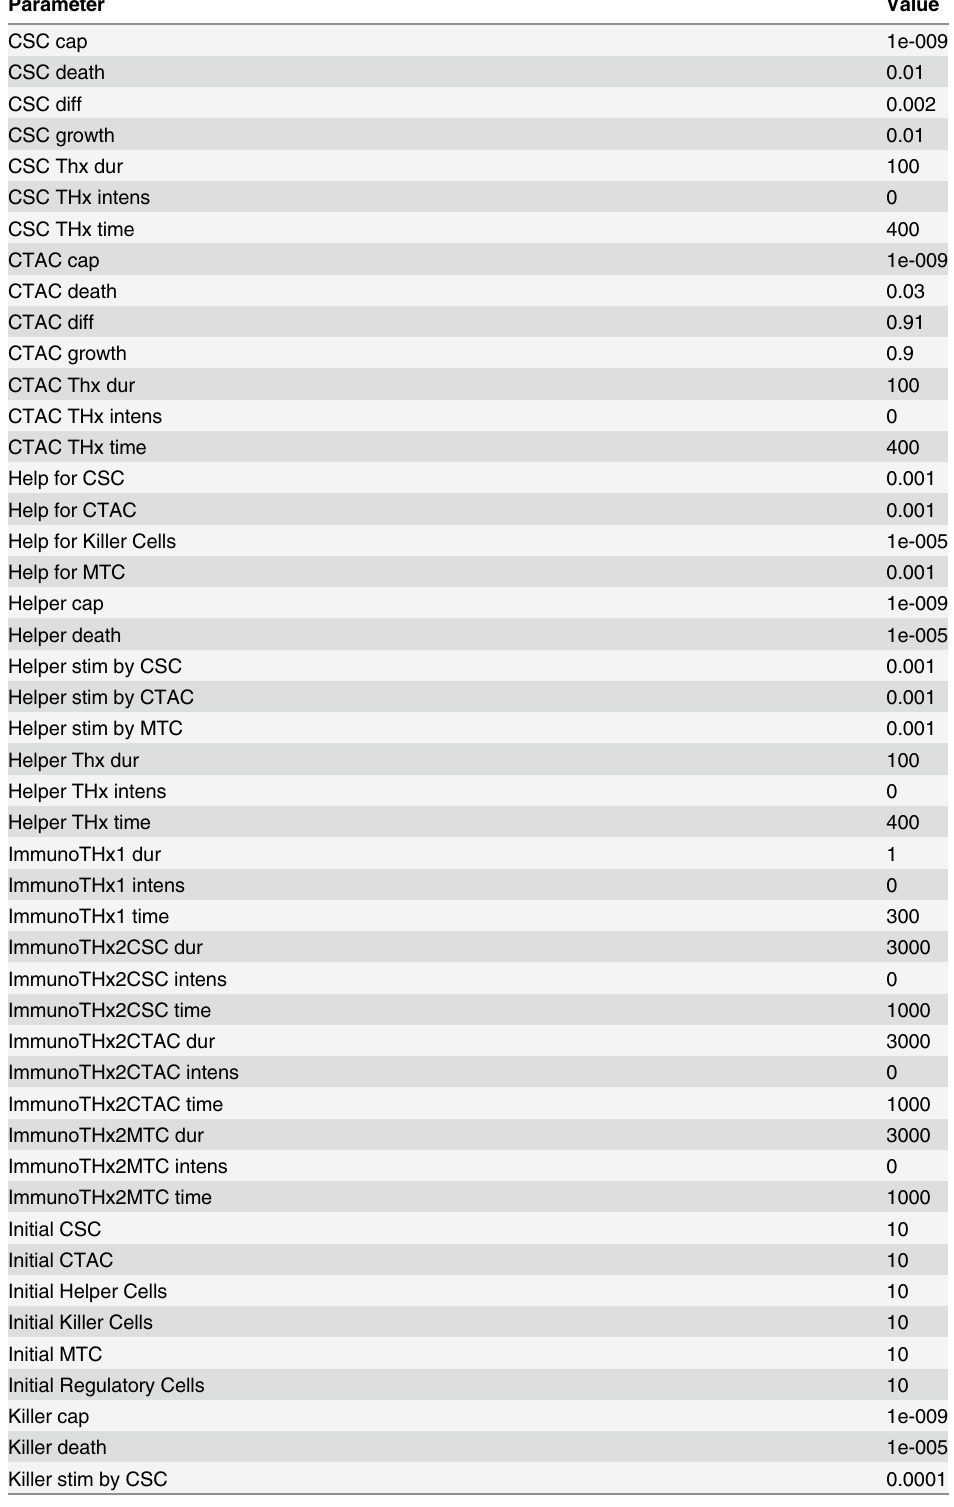
Table 1. Default values used in the model (see Fig